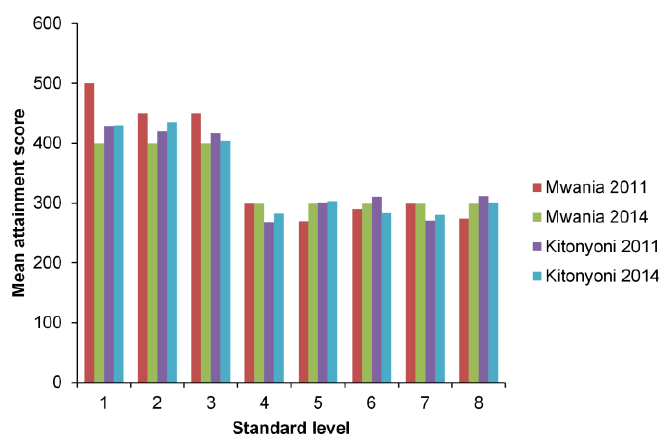
Figure 6. Mean attainment scores at primary schools in Kitonyoni and Mwania pre and post intervention, at Kenyan standard levels 1–8. The standard levels are Kenyan primary school ‘years’ (Standard Level 1 is the first year, corresponding to age 5–7 years old, while Standard Level 8 corresponds to 12–14 years old). Note that this is under the 8-4-4 system.